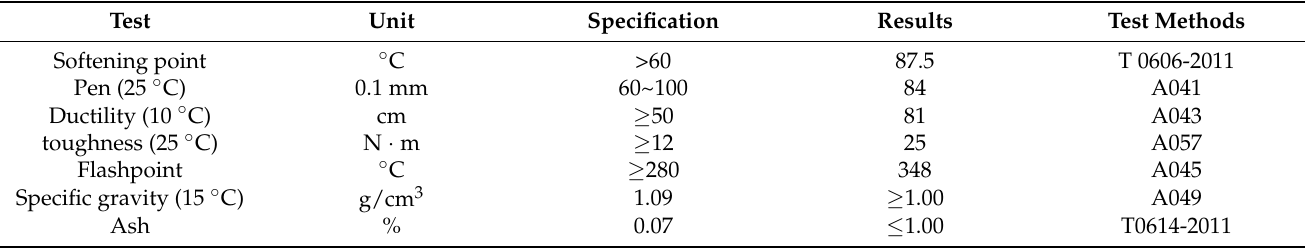
Table 1. Properties of the high-elasticity modified asphalt